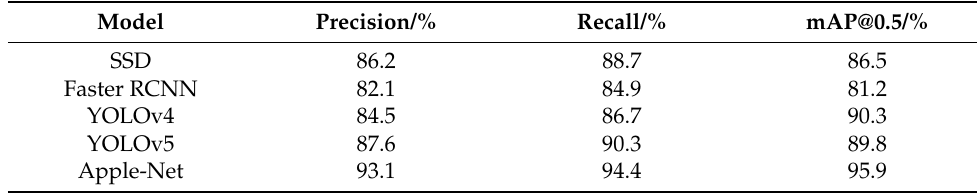
Table 2. Performance comparisons of different